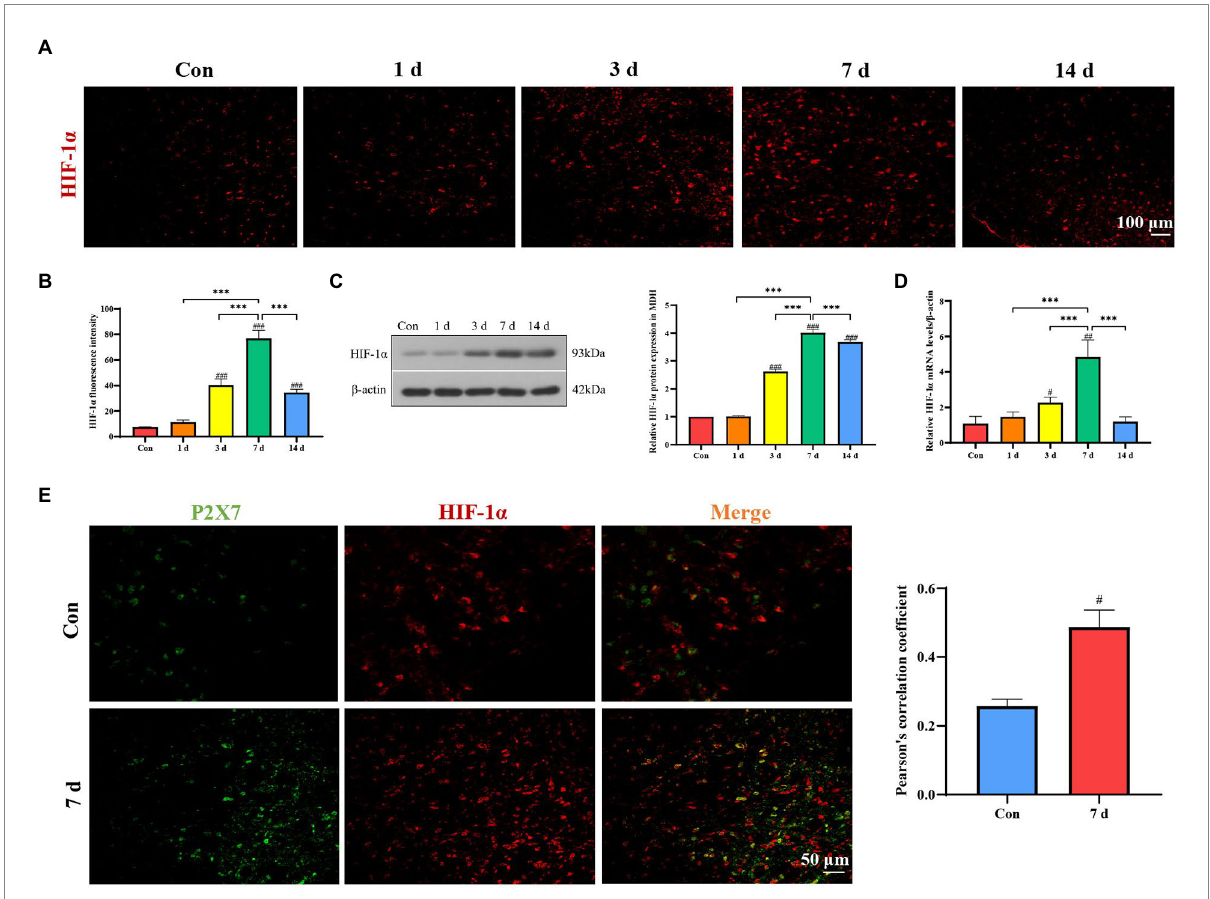
FIGURE 4 Expression of HIF-1 α in MDH after dental pulp exposure. (A,B) Immunofluorescence staining showed that expression of HIF-1 α in MDH gradually increased with a prolonged exposure time of the dental pulp. (C) Western blot analysis showed that HIF-1 α protein levels significantly increased compared to the control group, with the highest expression on the seventh day. (D) The mRNA levels of HIF-1 α increased with the highest expression on the seventh day. (E) Double immunofluorescence staining revealed that P2X7 is colocalized with HIF-1 α in MDH. *** p < 0.001